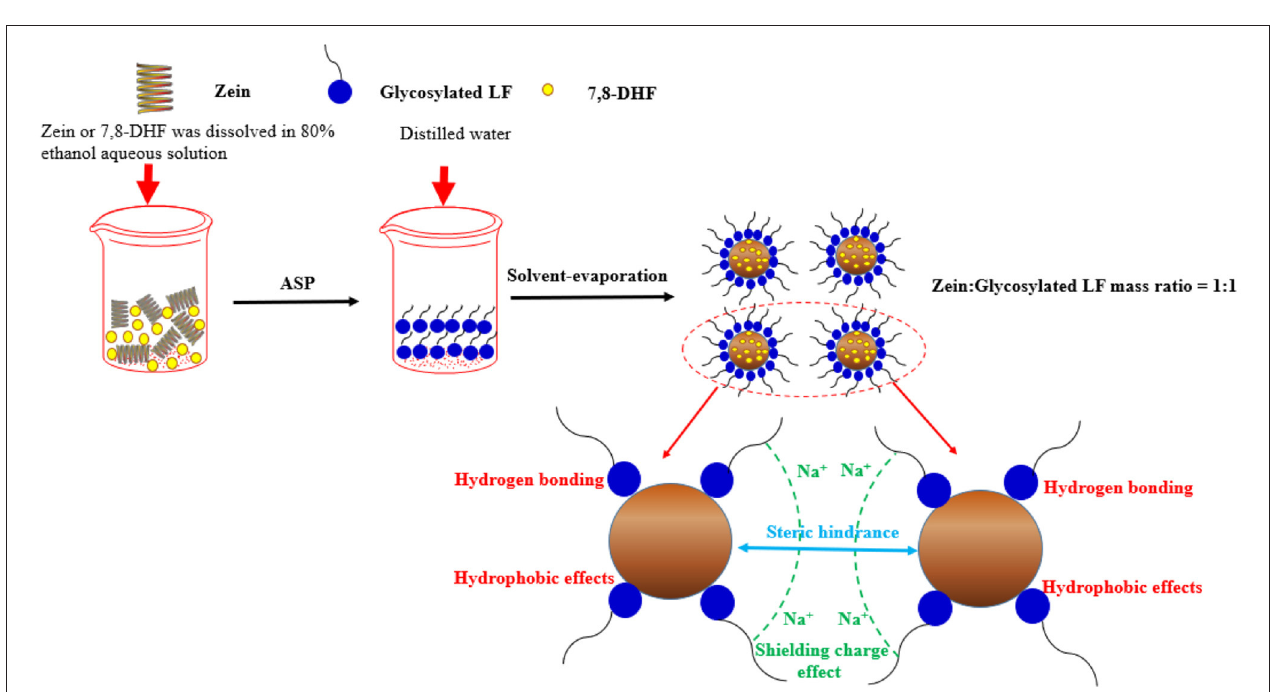
FIGURE 8 | An illustration of the formation and stability mechanism of DHF-zein/glycosylated LF.